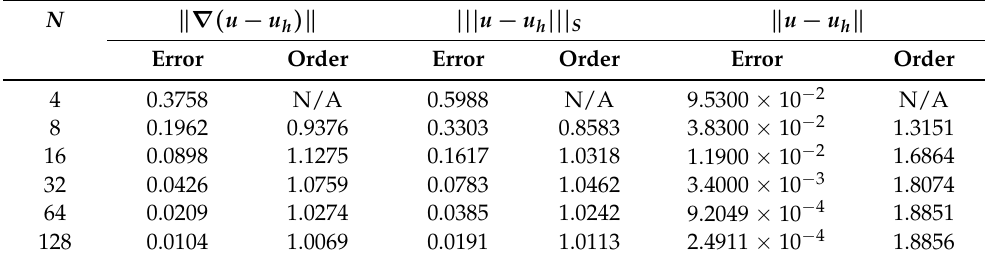
Table 9. Experiment results for the exact solution u = x 2 + e y with B.C. V.